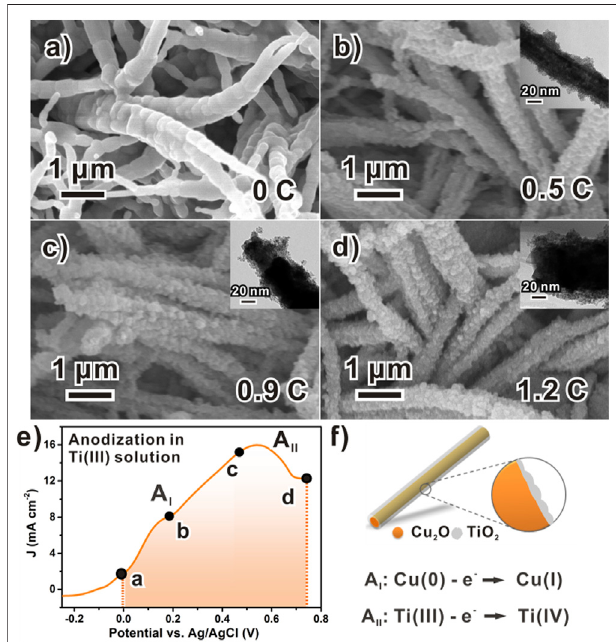
FIGURE 4 | Chronology of TiO x formation in potentiodynamic anodization process: (A) Scanning electron microscope images of bare Cu 2 O NWAs; (B – D) Corresponding scanning electron microscope images showing morphological evolution of amorphous TiO x along with increasing anodization charge. (E) Typical LSV curve of anodizing a piece of Cu 2 O foil with rate of 5 mV/s, data points labeled with charges specifying samples examined in parts b – d and (F) schematic model to formation of Cu 2 O/TiO x NWAs.